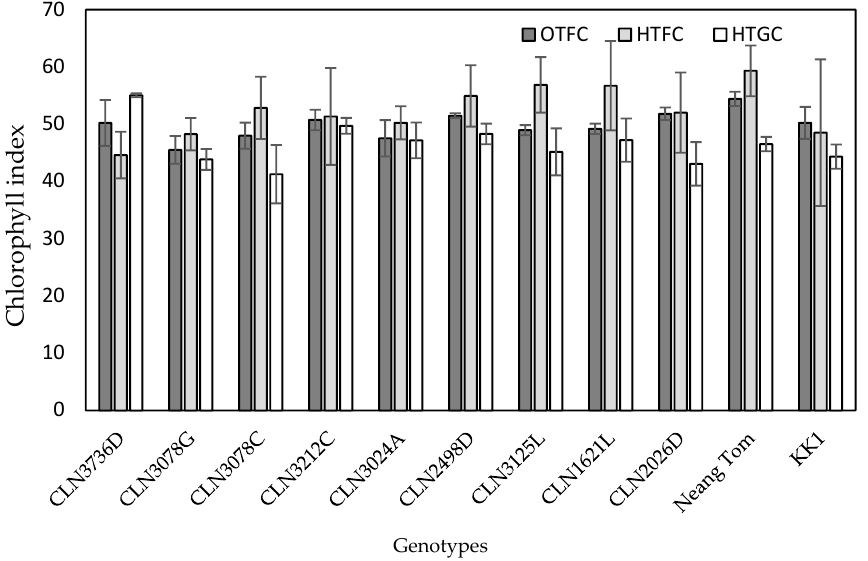
Figure 3. Chlorophyll index (SPAD readings) of the genotypes in both field (optimum temperature field condition (OTFC), high temperature field conditions (HTFC), and high temperature greenhouse conditions (HTGC). Value is the mean of three replications with the error bars which represent standard